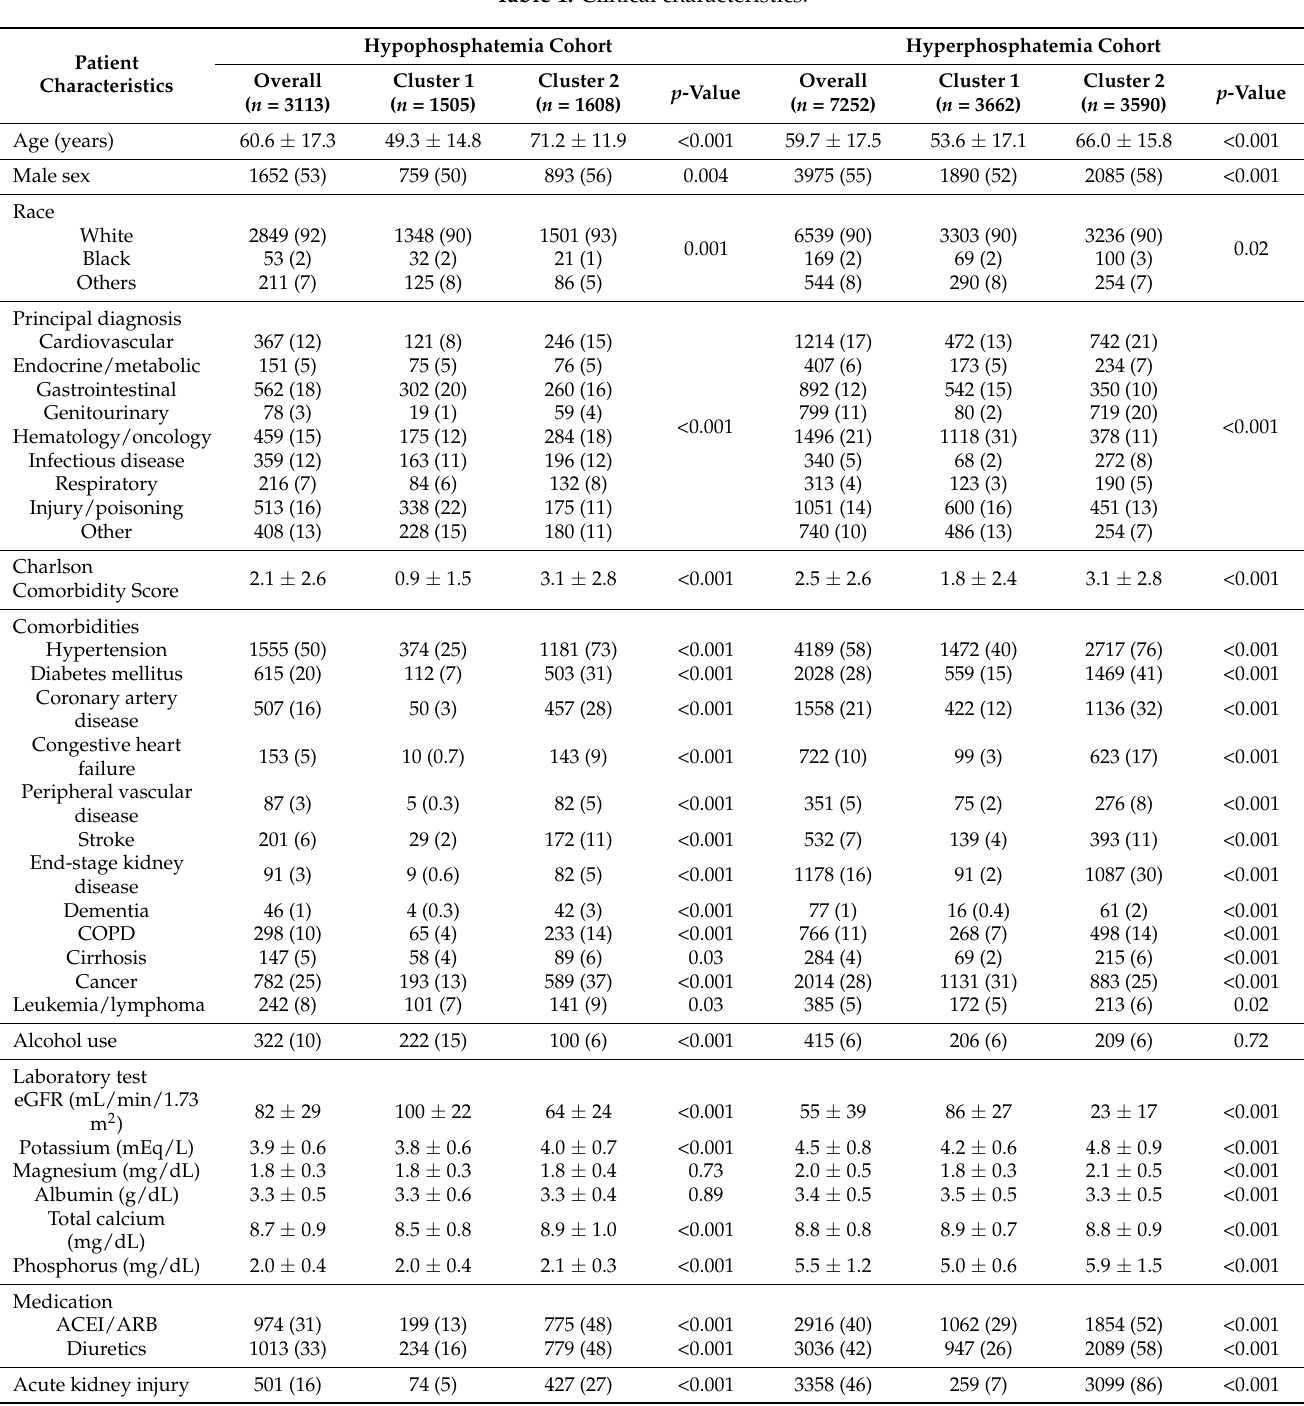
Table 1. Clinical